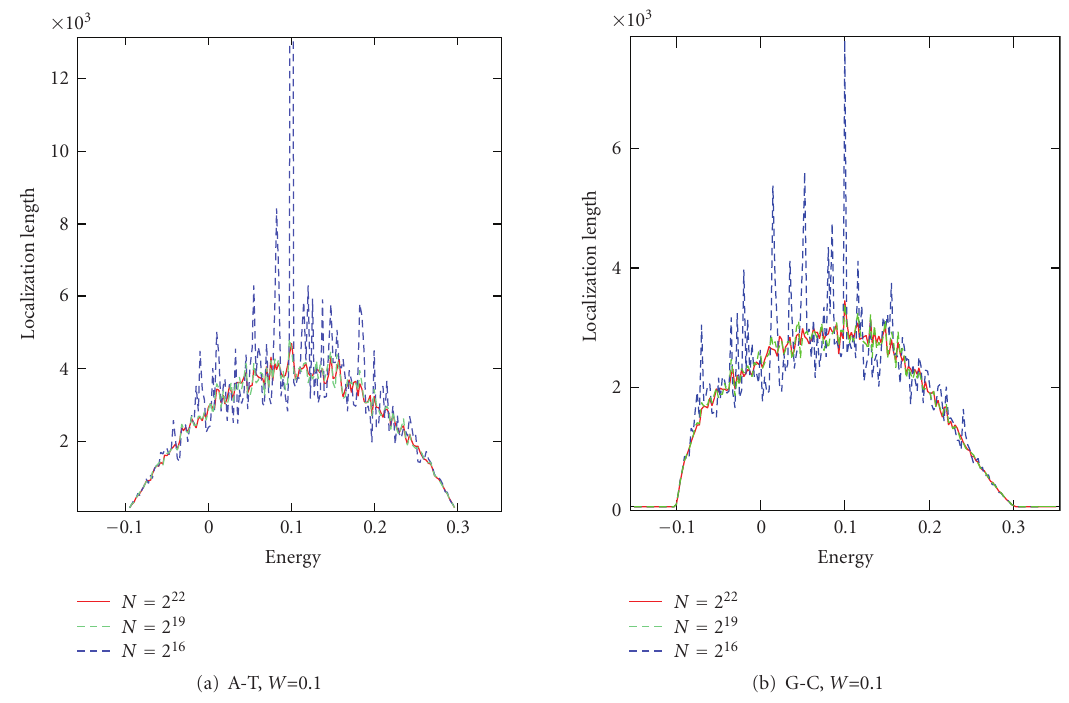
Figure 6: The localization length as a function of the energy for several system sizes N ( = 2 16 ,2 19 ,2 22 ) in the (a) poly(dA)-poly(dT) DNA polymers and (b) poly(dG)-poly(dC) DNA polymers. W = 0 . 1 and θ 0 = 36 ◦